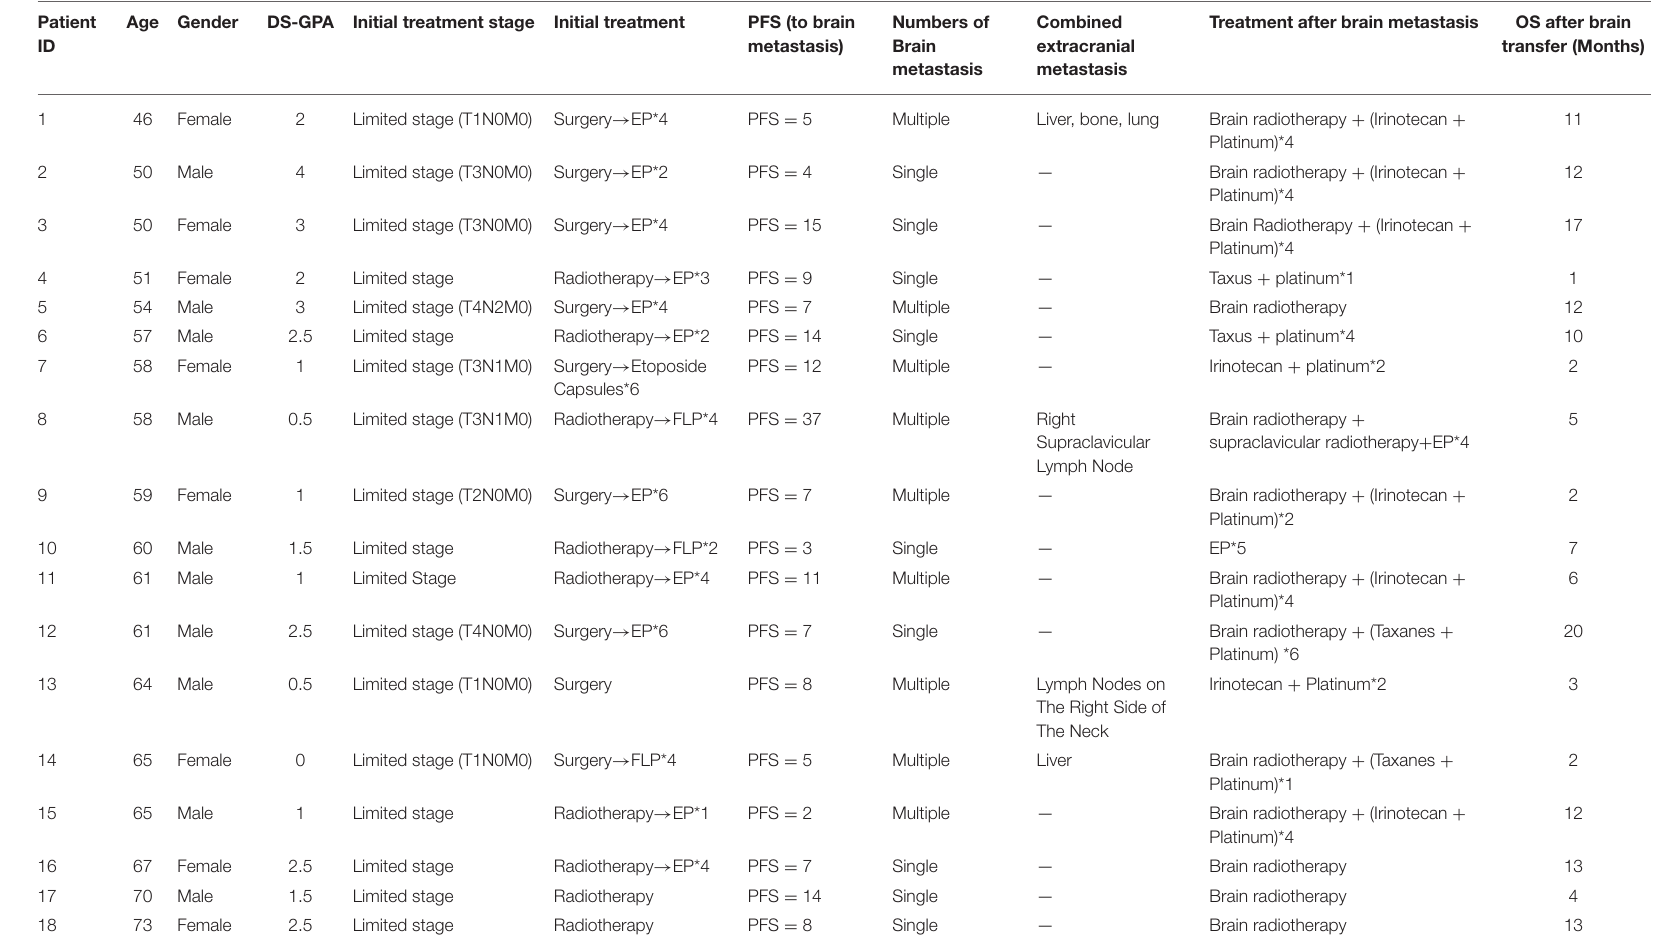
TABLE 2 | Treatment of 18 patients. Patient